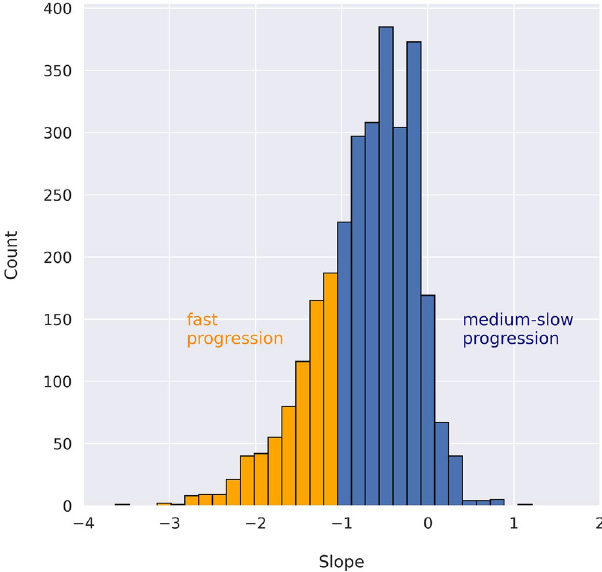
Figure 2. Distribution of the 3–12 months ALSFRS slope distribution and fast versus medium-slow progressors.